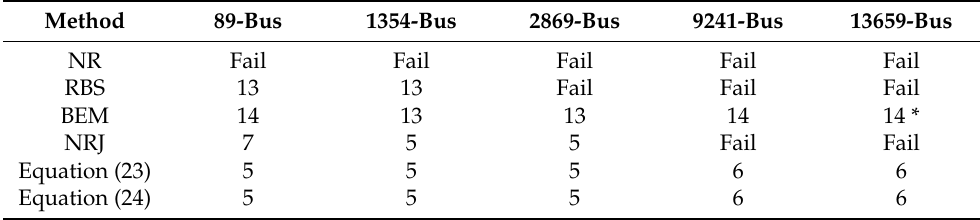
Table 3. Total iterations for base cases.